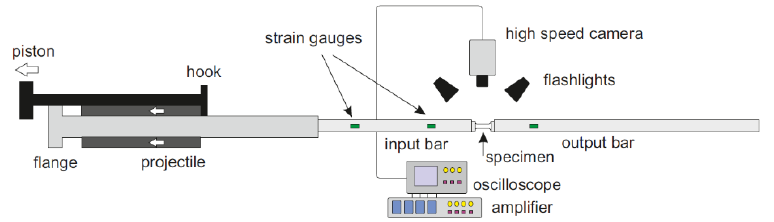
Fig. 2. Basic layout of the Split Hopkinson Tensile Pressure Bar at the University of Oxford Impact Engineering Lab.